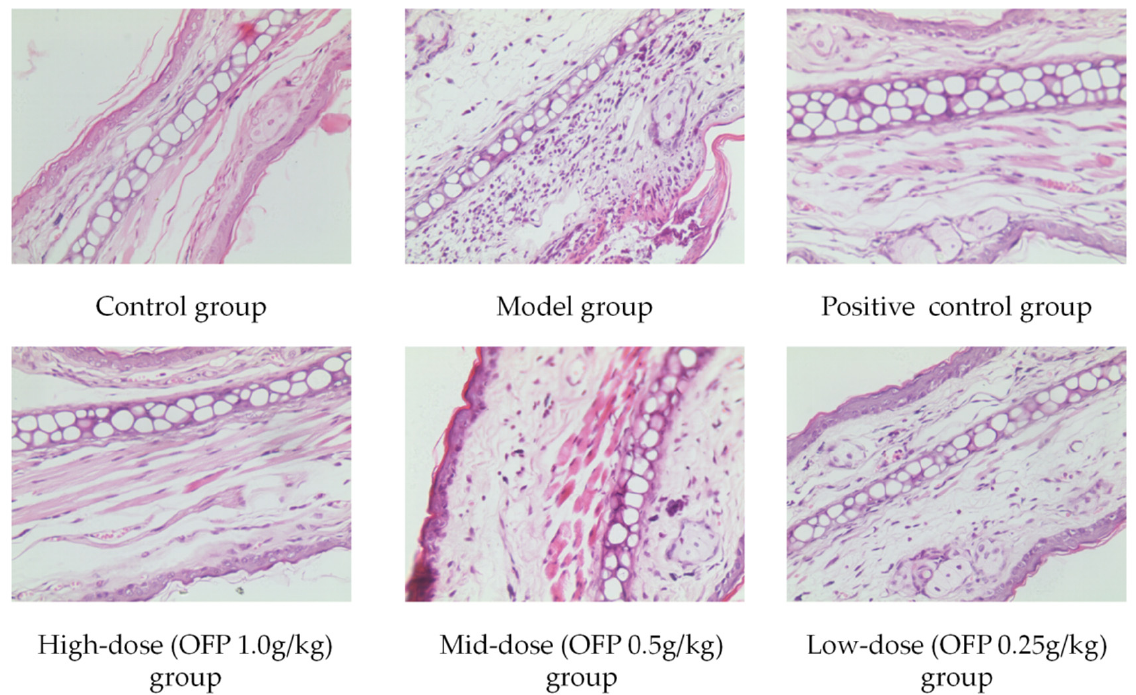
Figure 8. Effect OFP on ear-swelling response in mice. Tissue sections of mouse left auricle exposed to various concentrations of OFP. (H&E stain, 400X). Control group: No xylene applied; Model group: Application of xylene but no treatment; Positive control group: Application of xylene for treatment with aspirin; High/Mid/Low-dose group: Application of xylene for treatment with different concentrations of OFP.